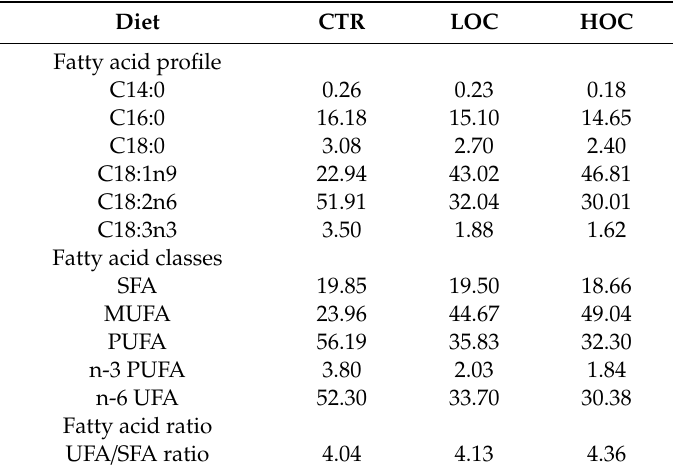
Table 2. Fatty acids of nutritional interest, fatty acid classes (g / 100 g fatty acid methyl esters (FAME)) # and UFA / SFA ratio of the